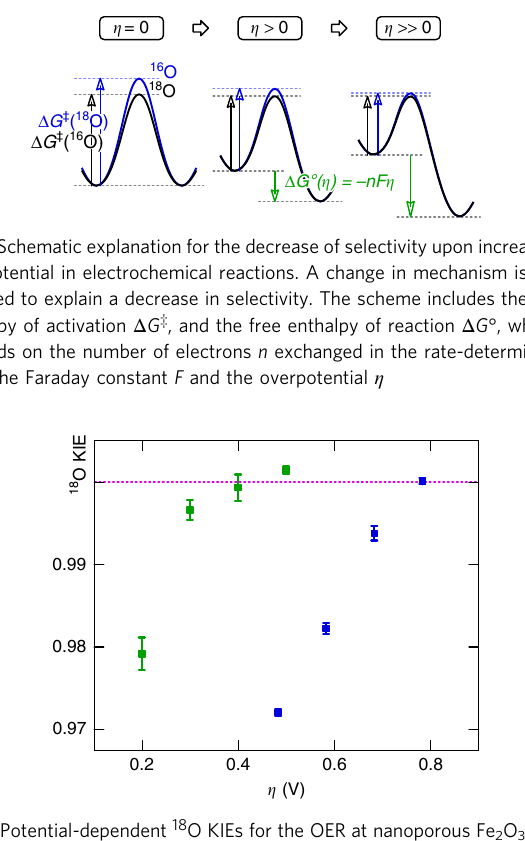
Fig. 4 Potential-dependent 18 O KIEs for the OER at nanoporous Fe 2 O 3 or Ir electrodes. 18 O KIEs of nanoporous Fe 2 O 3 (blue data points) or Ir (green data points) are presented for different applied overpotentials η . Steady- state electrolyses were performed in a 0.1 M KH 2 PO 4 solution (pH neutral) for 3 h or in a 0.1 M H 2 SO 4 solution for 0.5 h at Fe 2 O 3 and Ir electrodes, respectively. The 18 O KIEs presented are average values calculated from three nominally identical individual samples. Their corresponding standard deviations are shown as error bars. The unity KIE value is indicated by the dashed